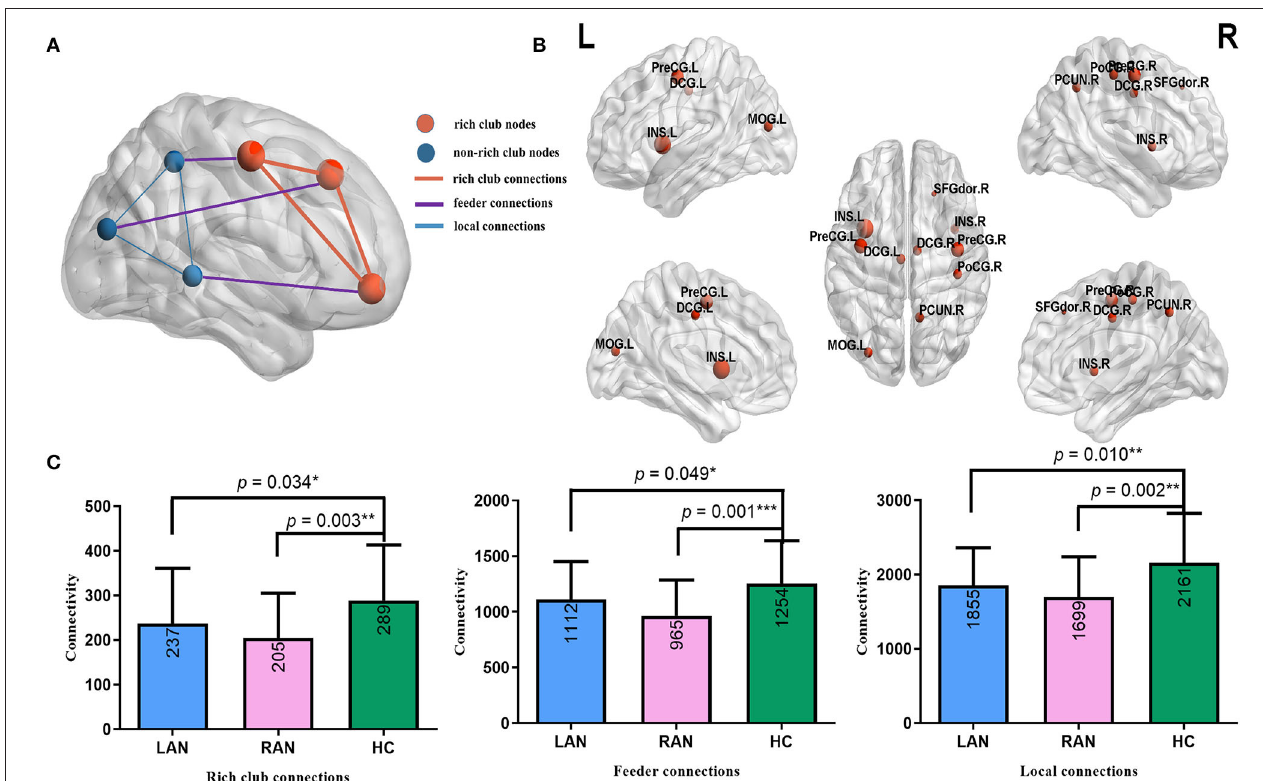
FIGURE 5 | The related results of rich club analysis. (A) Schematic diagram of rich club analysis. Red nodes represent rich club nodes, and blue nodes represent non-rich club nodes. Sorting by degree centralities from large to small, the first 12% were taken as rich club nodes. Rich club connections (red lines) refer to the edges that link rich club nodes in the network; local connections (blue lines) refer to the edges that link non-rich club nodes; feeder connections (purple lines) refer to the edges that link rich club nodes and non-rich club nodes in the network. (B) In this study, 10 rich club nodes are shown, namely bilateral precentral gyrus, bilateral median cingulate and paracingulate gyri, bilateral insular, left middle occipital gyrus, right postcentral gyrus, right precuneus, and right dorsolateral superior frontal gyrus. (C) The comparison results of rich club analysis. Compared to the HC group, all the connections in patients with LAN and RAN decreased. * p < 0.05, ** p ≤ 0.01, *** p ≤ 0.001. The numbers in the box represent mean values. Error bars represent mean ±